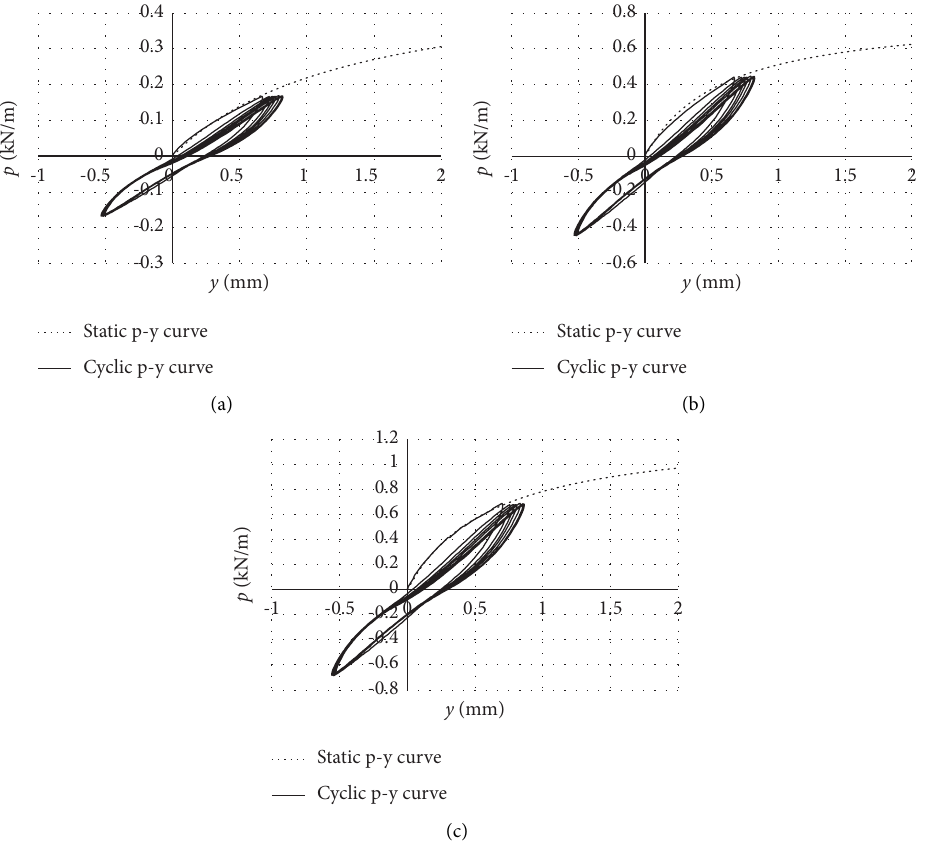
Figure 8: Experimental cyclic p - y curves at a depth of 2 D (loading amplitude of 0.6 H